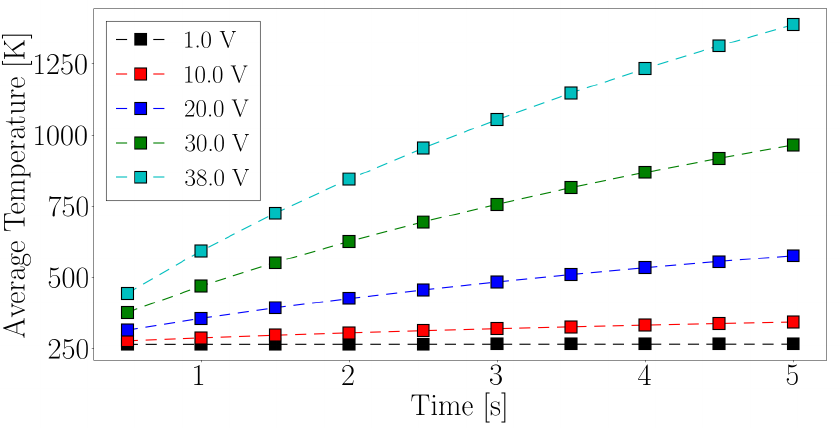
Figure 12. Electrical heating sensitivity analysis: struts’ domain average temperature profiles.